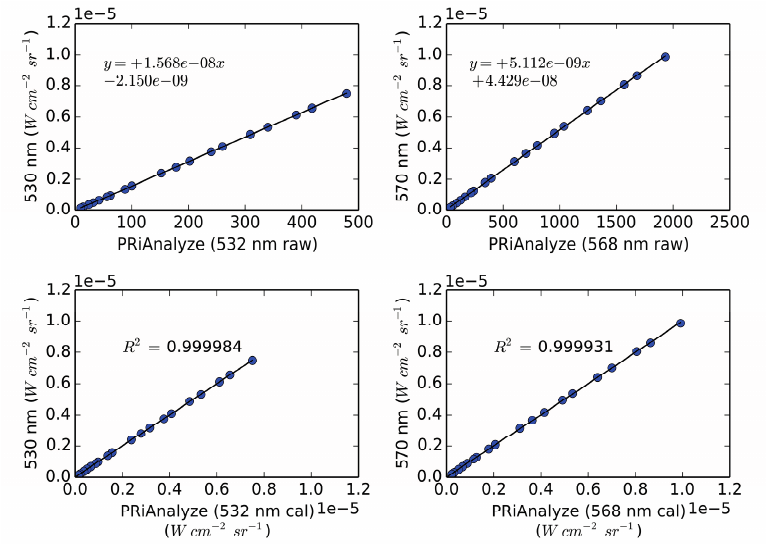
Figure 3. Correlations between the PRiAnalyze waveband data ( x -axis) and the calibrated light source ( y